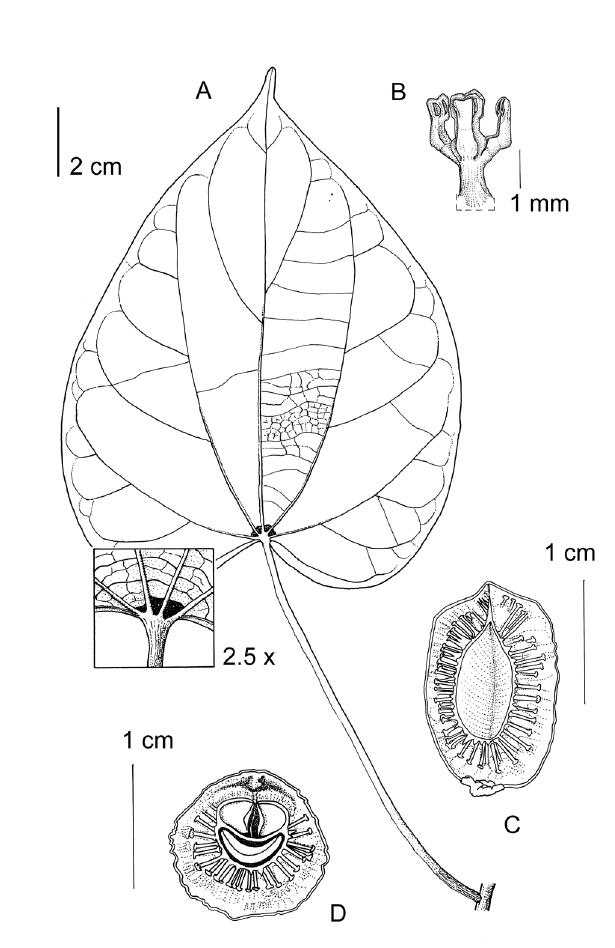
▲ Figure 14 – Distribution of Rhigiocarya peltata . Map created with ArcMap 10.7.1 (ArcGIS Desktop v.10.7.1; Esri 2019). © Esri and its licensors, all rights reserved.